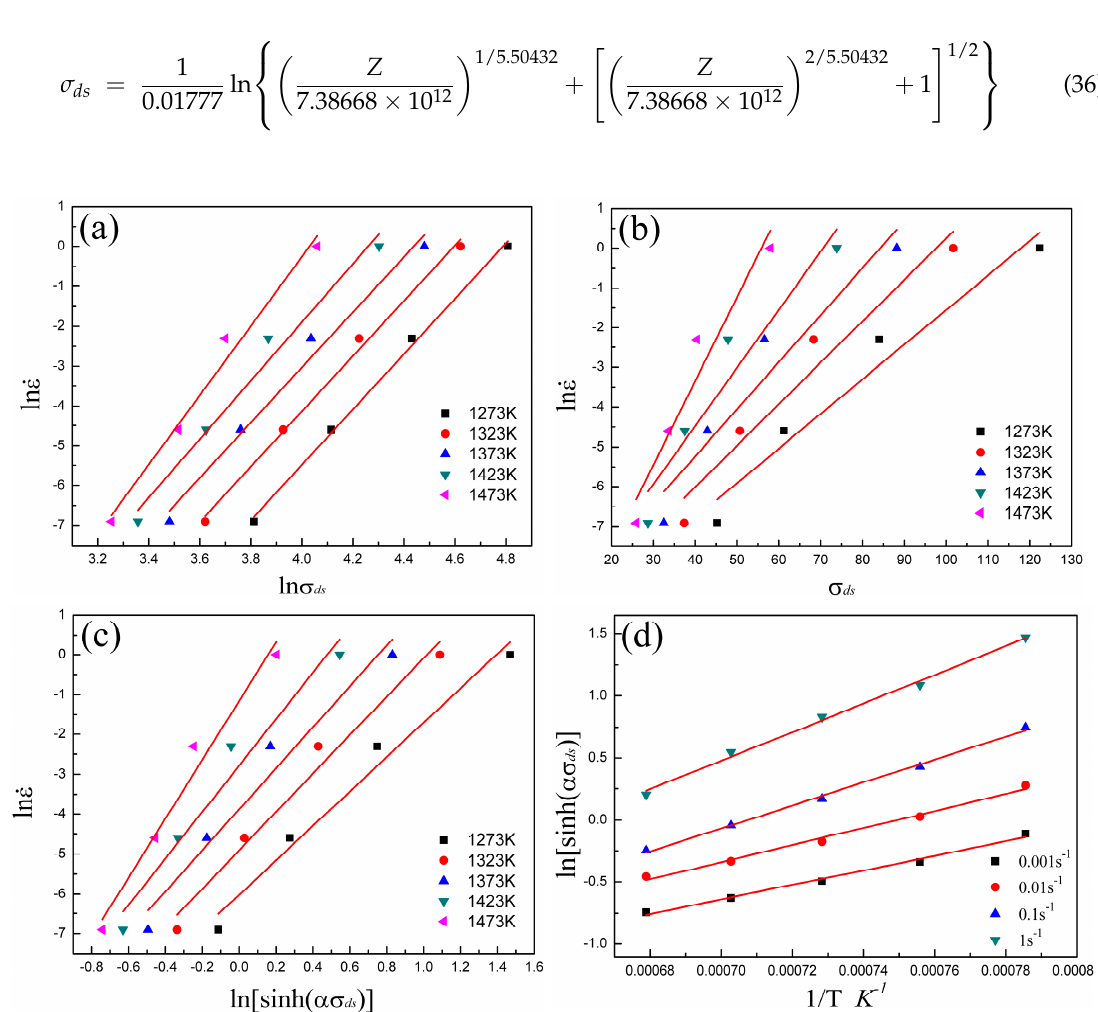
. σ ε , σ ds and T : ( a ) ln ε  , ds